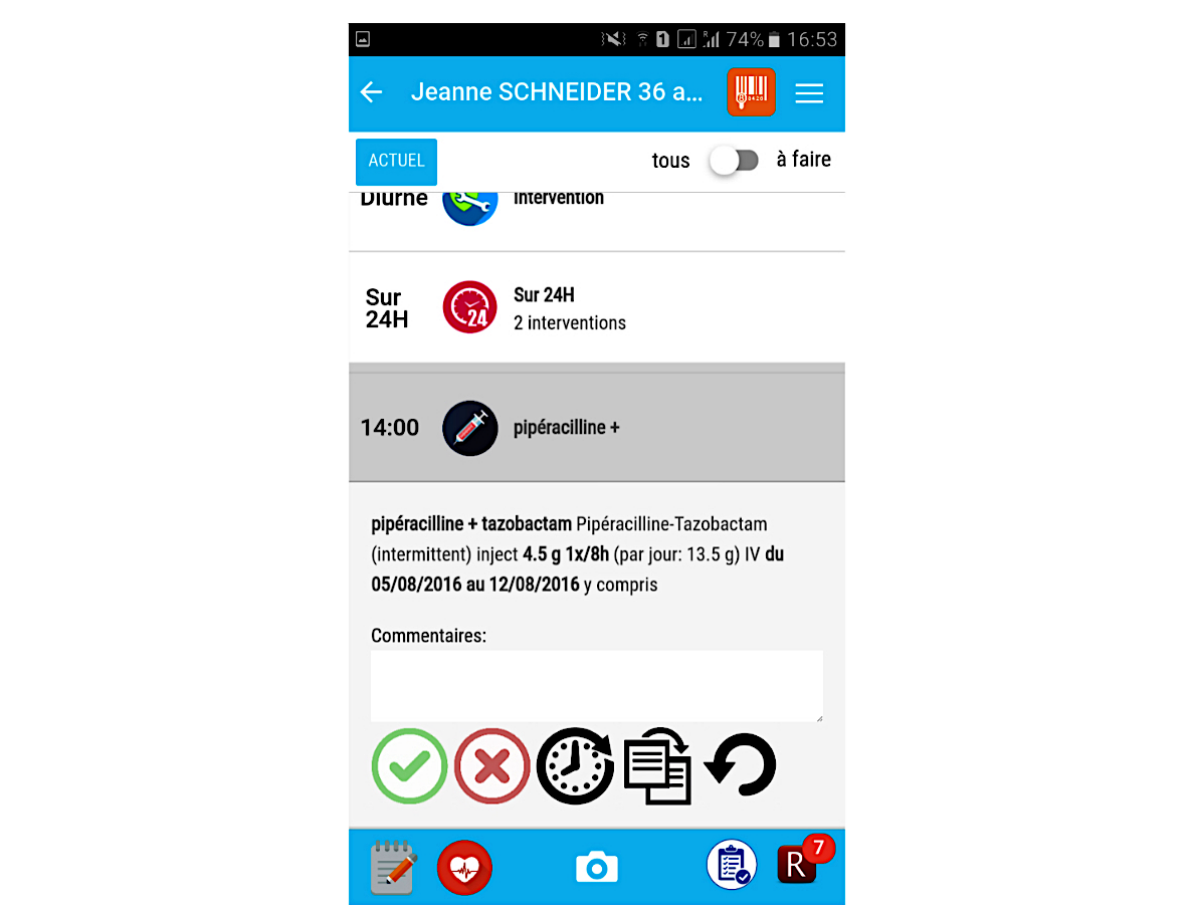
Figure 4. Problem with distinction of icons. The red “X” button is used to document an incomplete intervention and the “rounded arrow” button is used to undo the validation of a